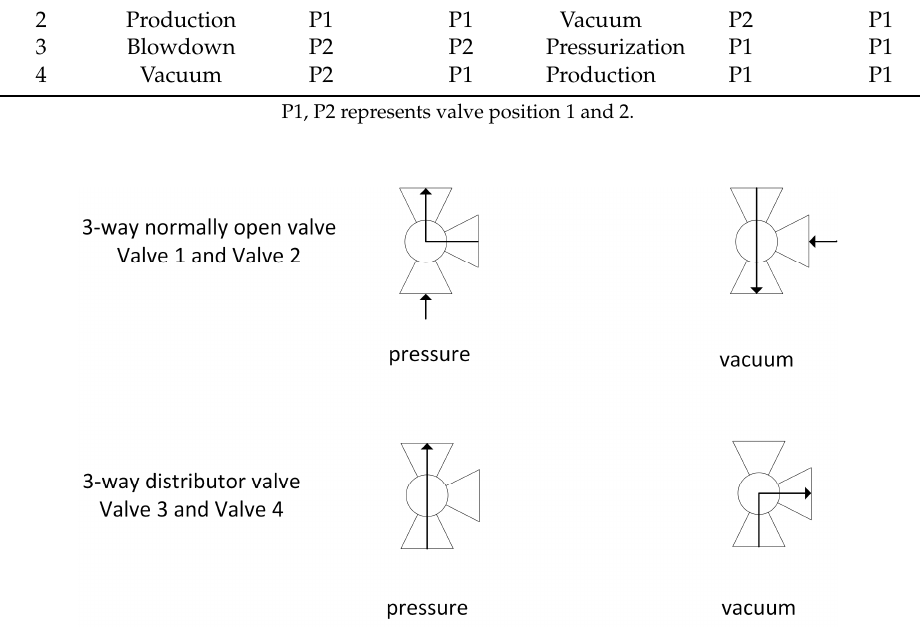
Table 1. The valve operation sequence for the PVSA cycle.